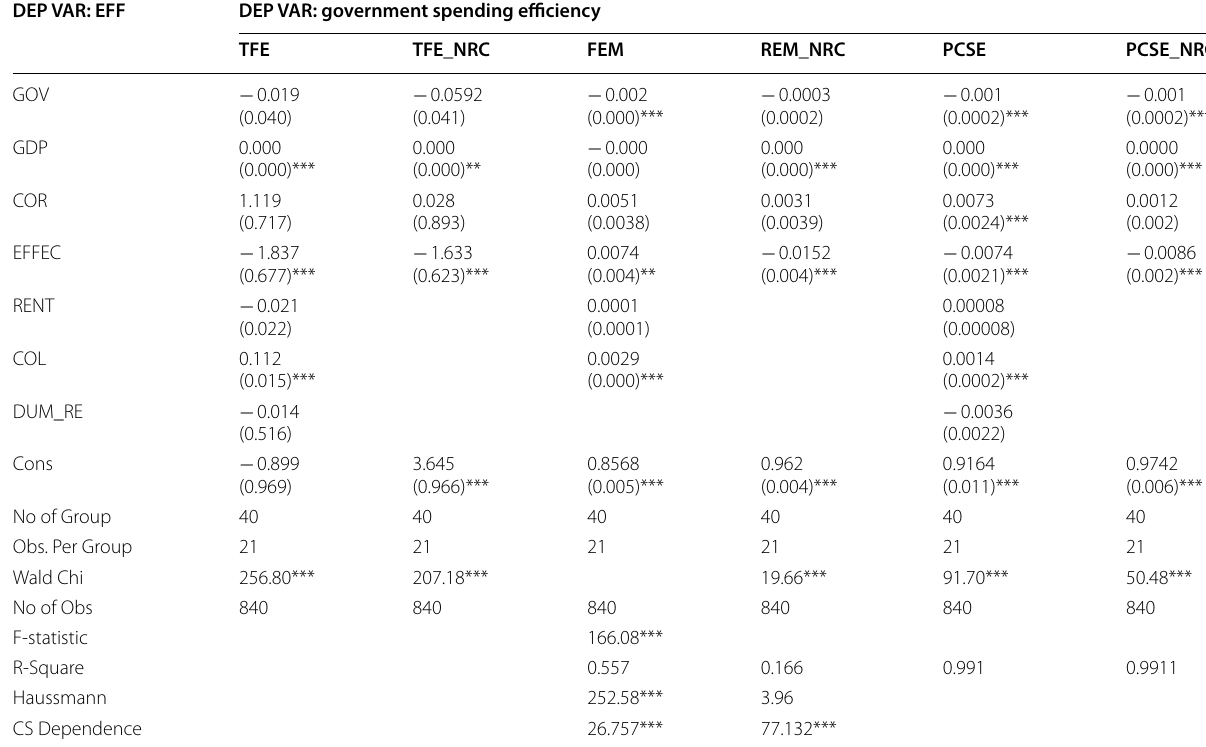
Table 8 Drivers of government spending efficiency in African